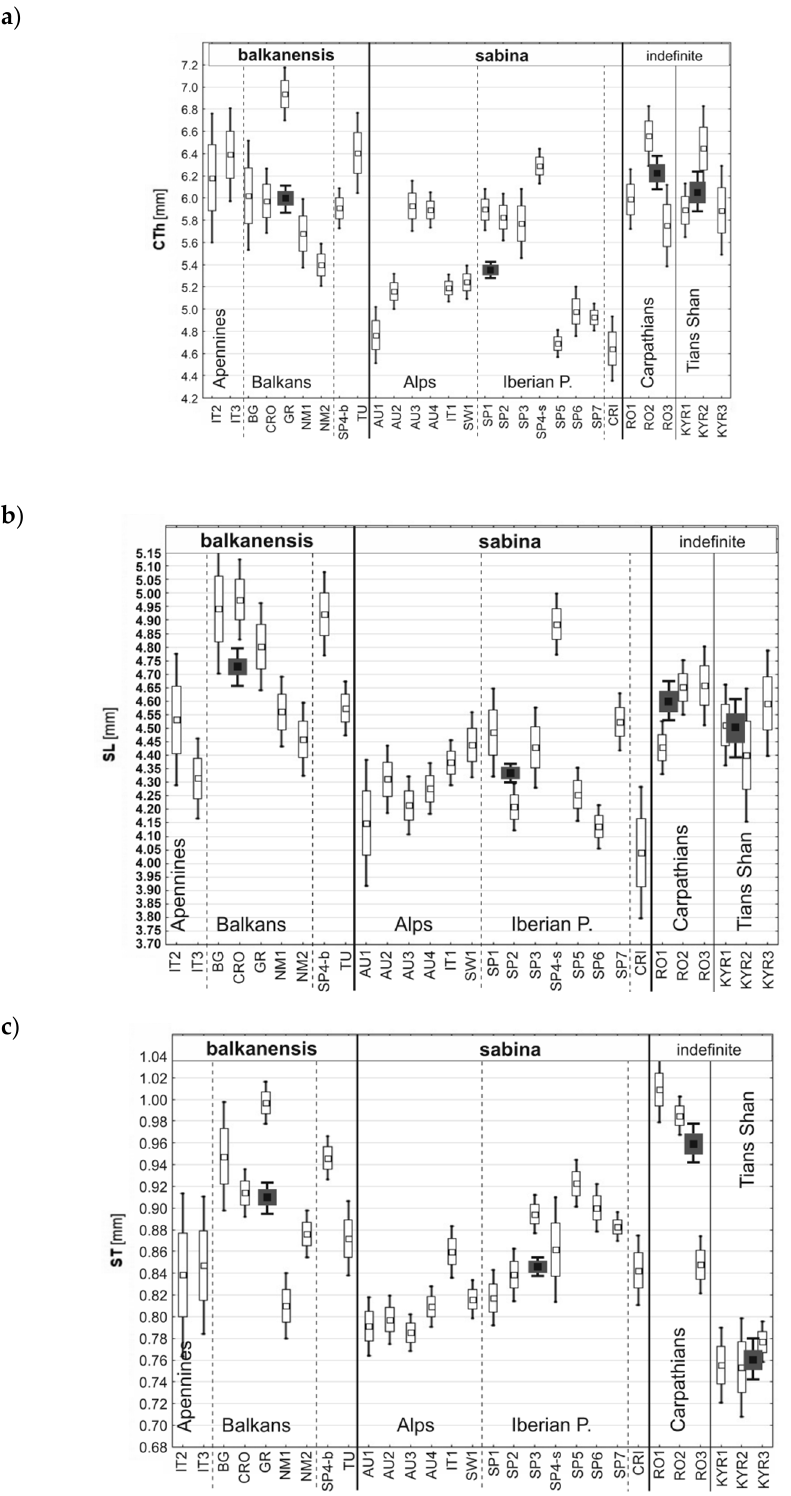
Figure 2. Box-and whiskers plot of characters important for inter-specific differentiationg of J. sabina : ( a ) CTh-cone thickness; ( b ) SL-seed length; ( c ) ST-shoot thickness. Point-mean. Box-standard error. Figure 2. Box − and whiskers plot of characters important for inter − specific differentiationg of J. Whiskers-1.96 standard error. Empty box-and-whiskers-for populations. Filled box-and whiskers-for sabina : ( a ) CTh − cone thickness; ( b ) SL − seed length; ( c ) ST − shoot thickness. Point − mean. varieties and indefinite groups. Populations acronyms as in Table Box − standard error. Whiskers − 1.96 standard error. Empty box − and − whiskers − for populations. Filled box − and whiskers − for varieties and indefinite groups. Populations acronyms as in Table 1.